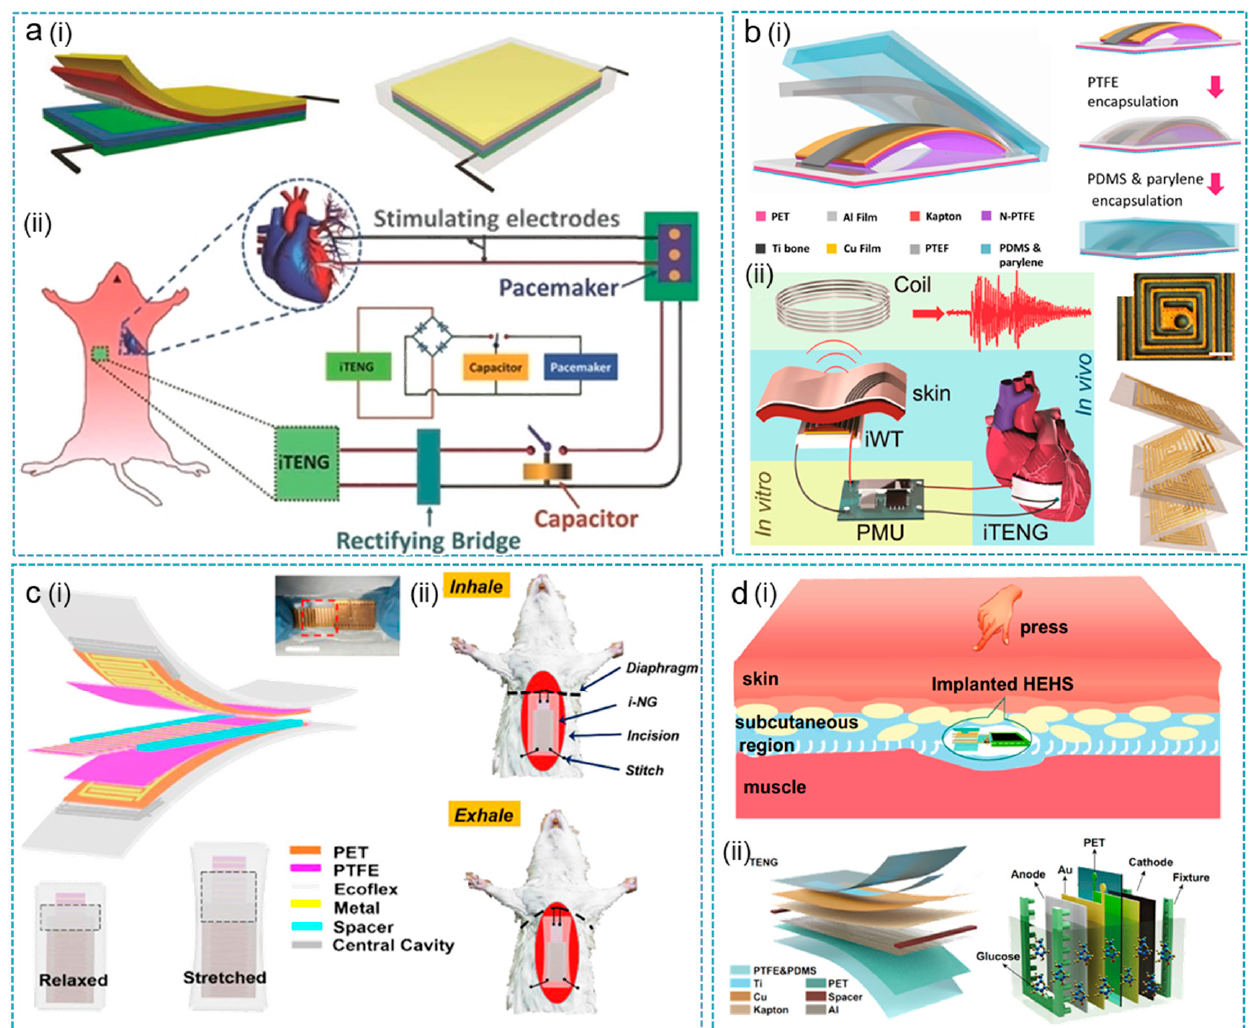
Figure 4. TENGs as in vivo energy harvesters. ( a ) In vivo power source for pacemaker driven by breathing. (i) The structure diagram of the implanted TENG (iTENG). (ii) Schematic diagram of iTENG for powering a pacemaker. Reprinted with permission from Ref. [144]. Copyright 2014 John Wiley & Sons. ( b ) In vivo self-powered wireless cardiac monitoring driven by heartbeat. (i) Structure diagram of the implanted TENG (iTENG). (ii) The self-powered wireless transmission system based on the iTENG. Reprinted with permission from Ref. [3]. Copyright 2016 American Chemical Society. ( c ) In vivo breath energy harvester. (i) Structure diagram of the implantable generator (i-NG). (ii) The i-NG for in vivo breath energy harvesting. Reprinted with permission from Ref. [105]. Copy- right 2018 American Chemical Society. ( d ) TENG integrated with a hybrid biofuel cell (EHES) for bioenergy harvesting. (i) Conception graph of an implanted HEHS for biomechanical and biochem- ical energy in body. (ii) Structure diagram of the TENG and biofuel cell. Reprinted from Ref. [51]. Copyright 2020 Springer.